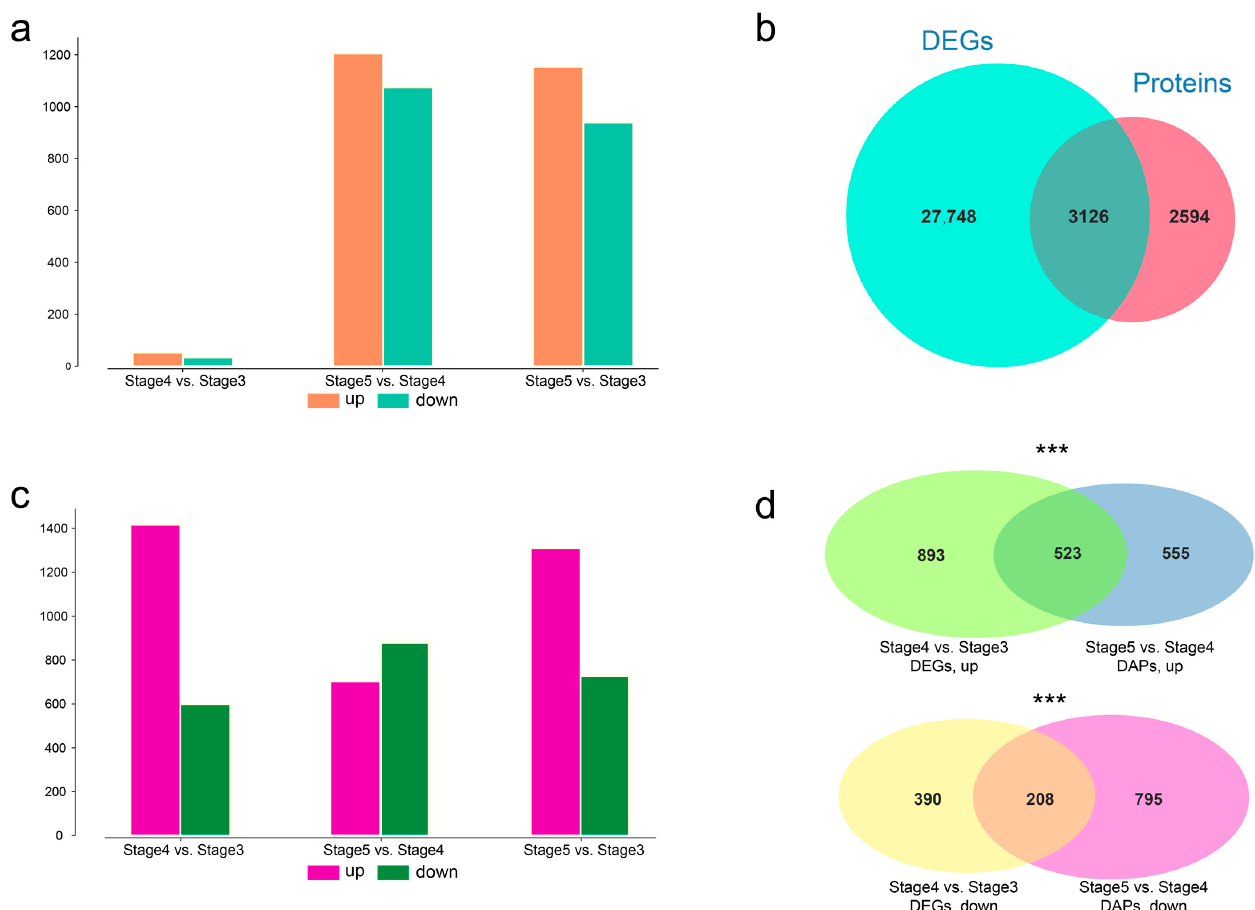
Figure 2. Comparative analysis between differentially abundant proteins (DAP) and differently expressed unigenes (DEGs). ( a ) Numbers of upregulated and downregulated DAPs at pairwise stages. ( b ) Venn plot between DEGs and identified proteins. ( c ) Numbers of upregulated and downregulated DEGs at pairwise stages. ( d ) Venn plot between DEGs of stage 4 and stage 3 and DAPs of stage 5 vs. stage 4. Upregulated DAPs and DEGs are shown at the top, and downregulated DAPs and DEGs are shown at the bottom. Asterisks indicate degree of significance (*** p <